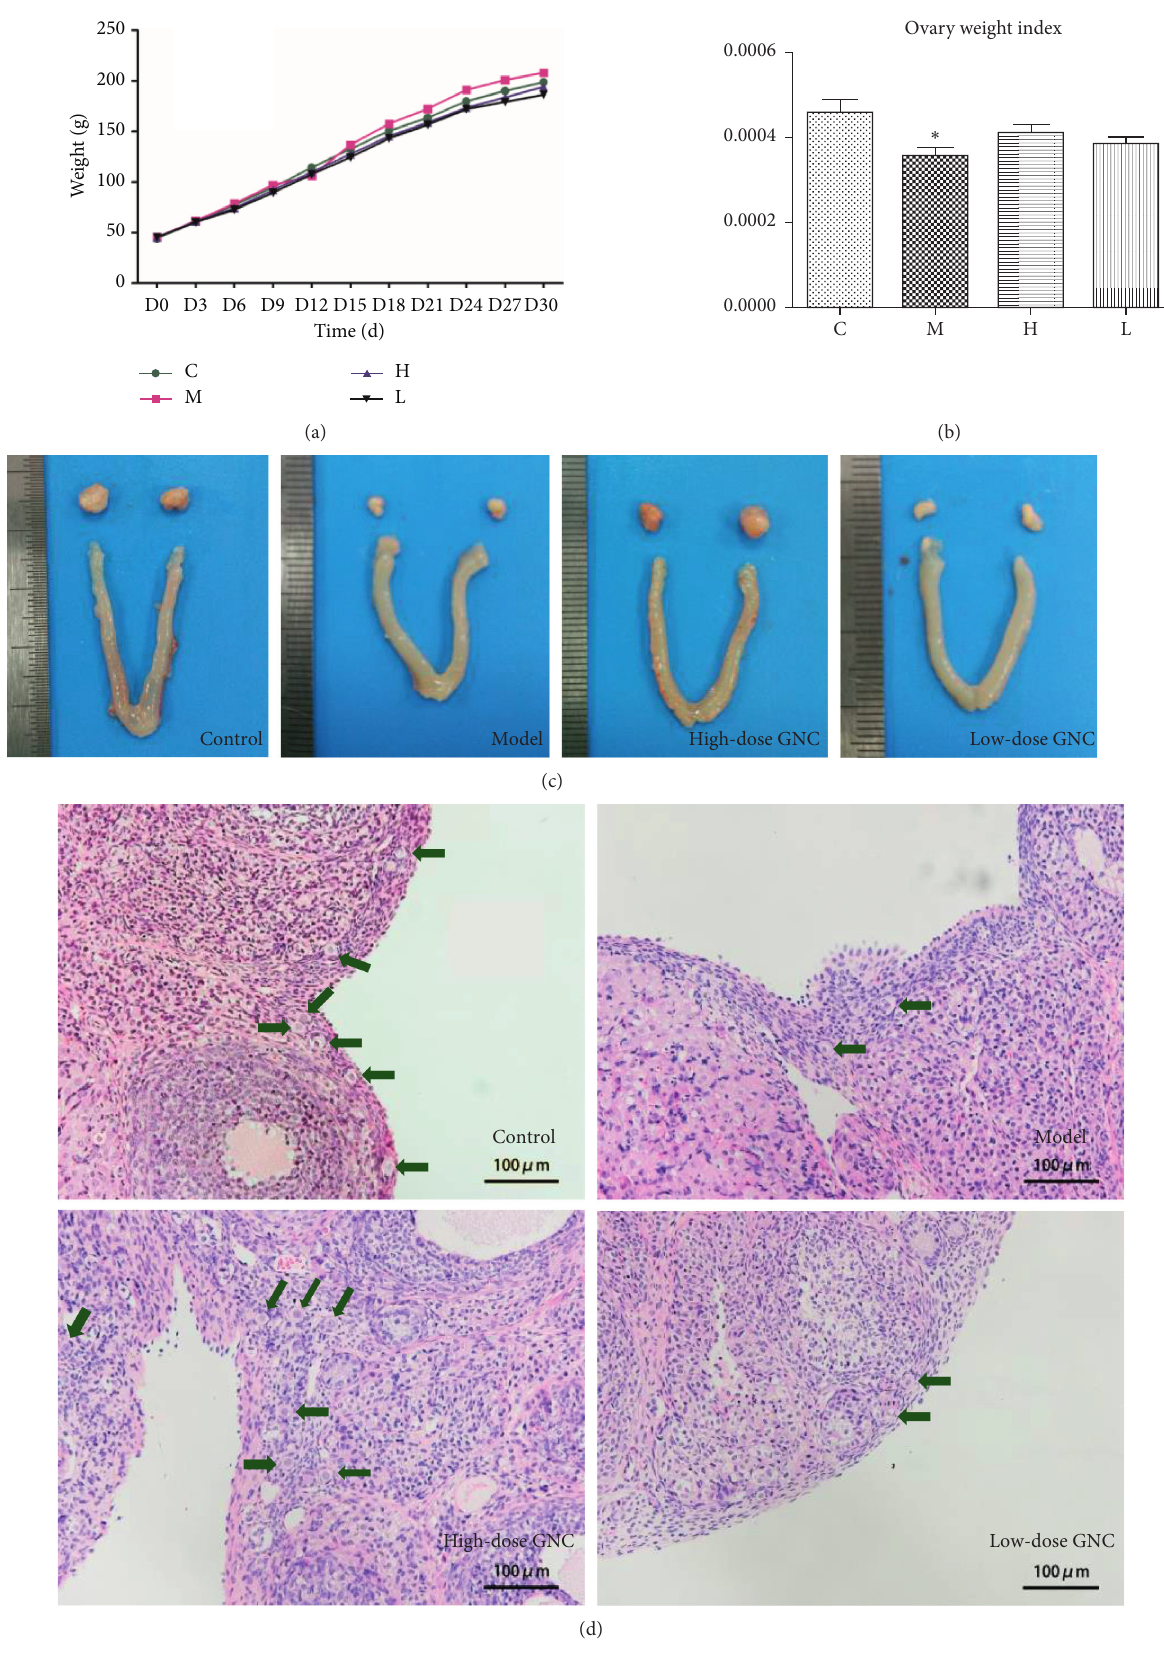
Figure 1: General conditions of rats and reproductive organs in different groups. (a) Bodyweight changes of rats in each group during experimental manipulation. (b) Ovarian weight index of rats in each group. (c) The representative appearance of ovaries and the uterus of rats in each group. (d) Representative view of HE staining of ovaries under a microscope. The brown arrows indicate primordial